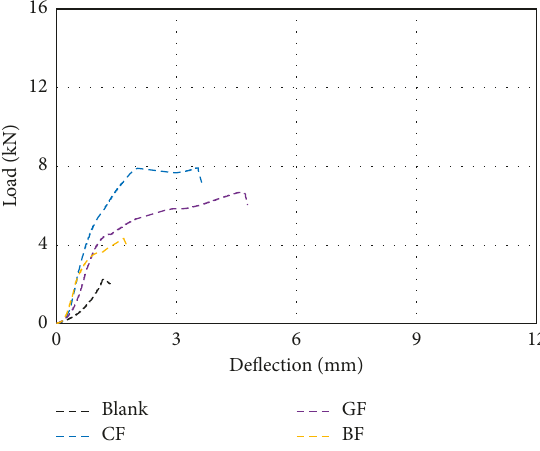
Figure 16: Load-deflection curves at − 10 ° C.